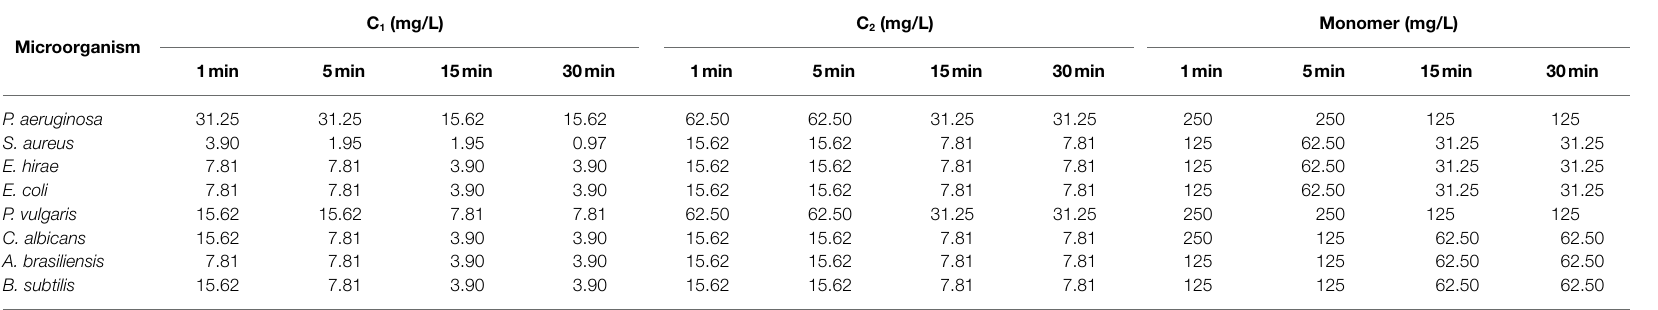
TABLE 6 | Organic matter protection test results.